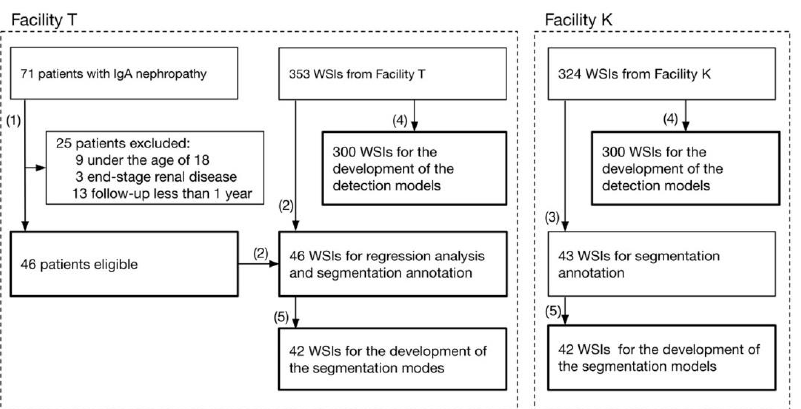
Figure A1. Overview of the data collection and selection procedure. (1) Eligibility criteria of immu- noglobulin A nephropathy (IgAN) for regression analysis. (2) Facility T: whole slide image (WSI) selection for regression analysis and segmentation annotation. (3) Facility K: WSI selection for seg- mentation annotation. (4) WSI selection for the development of glomerular detection models. (5) WSI selection for the development of the glomerular segmentation models. Bold boxes indicate the data used in the experiments described below.